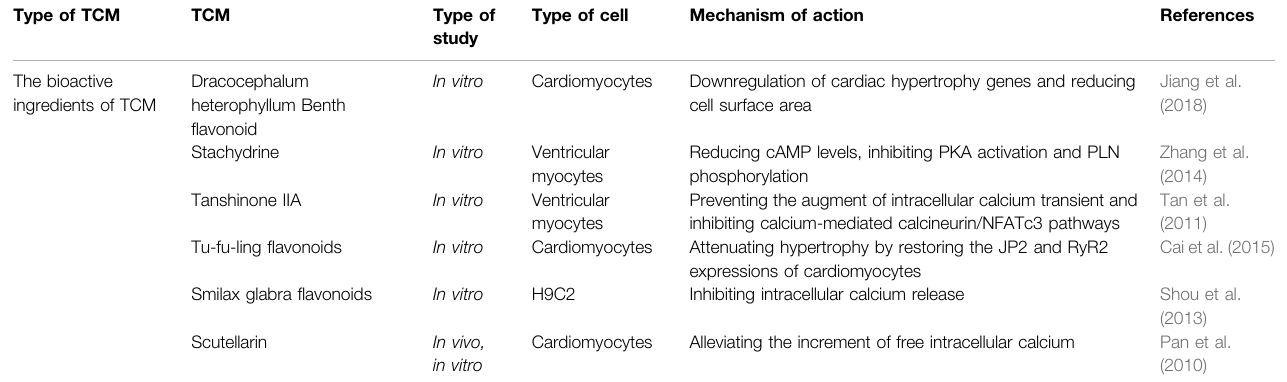
TABLE 1 | The mechanism of TCM in the treatment of cardiac hypertrophy through calcium signaling.